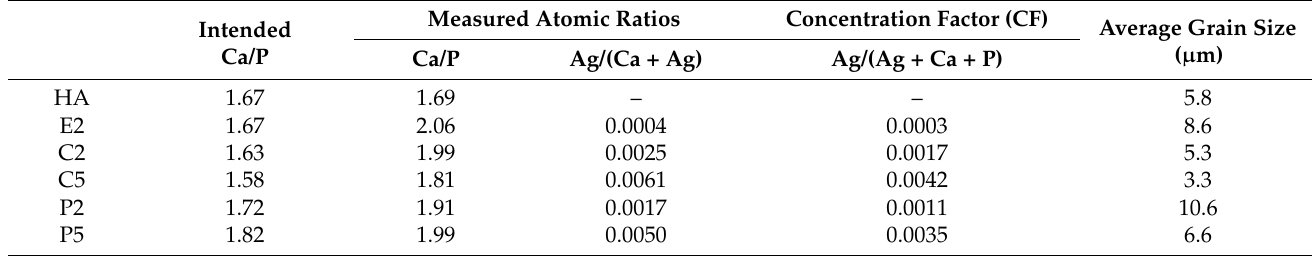
Table 2. Measured composition and atomic ratios of the AgHA series heat treated at 1100 ◦ C and corresponding average grain sizes.